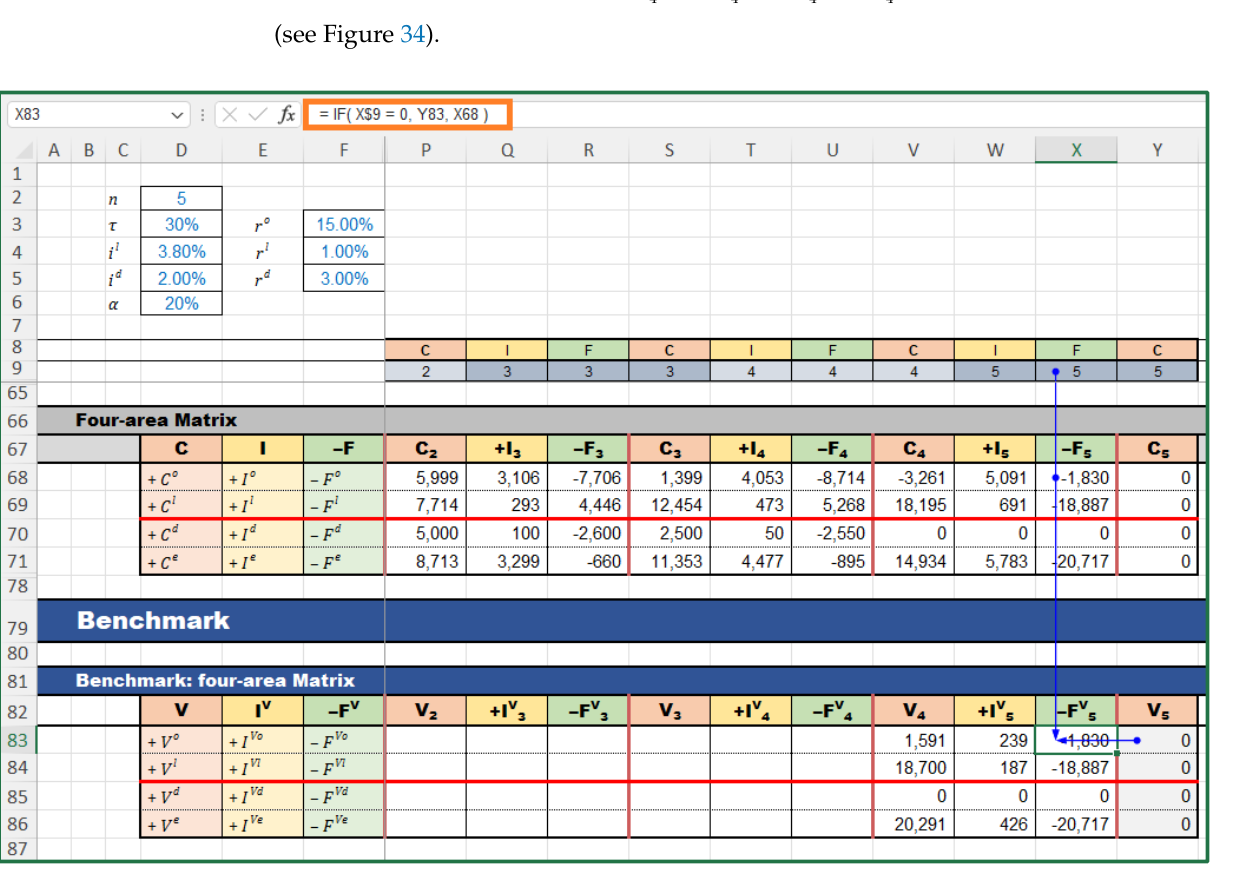
Figure 34. Cell X83 contains the formula for calculating the CFO (“SplitScreenStrip” sheet).